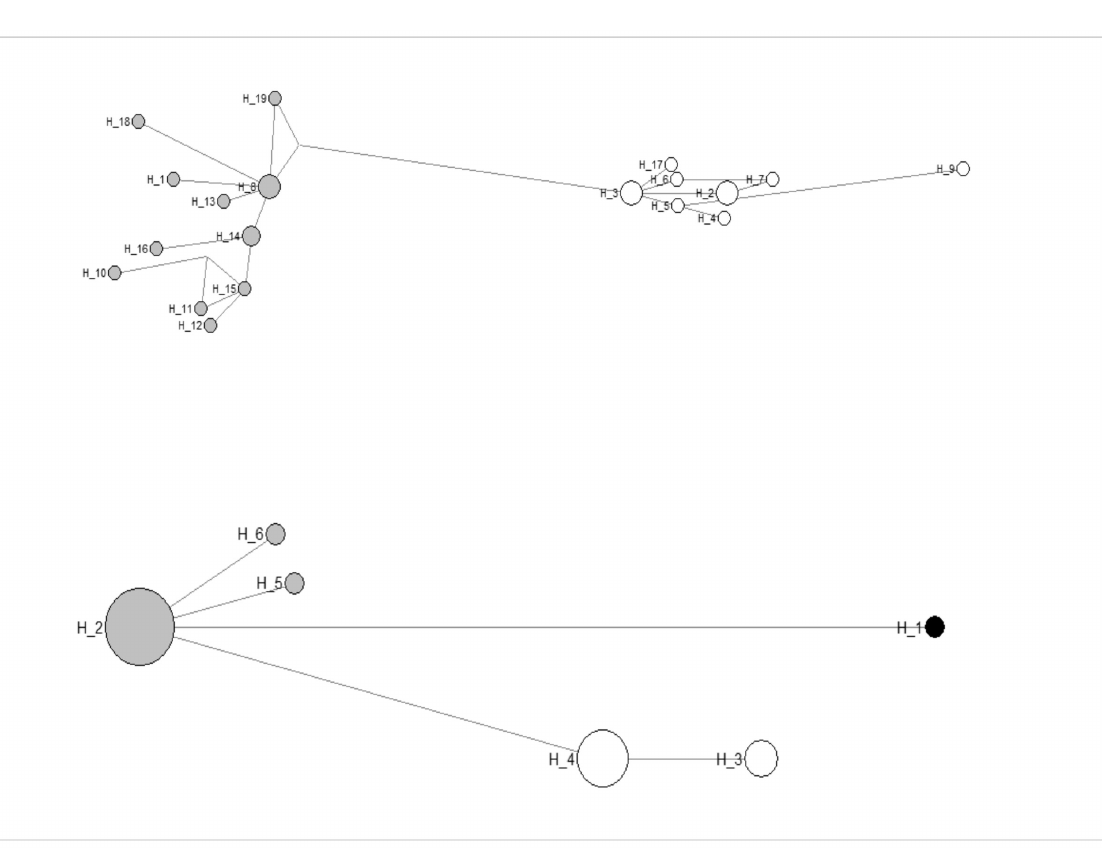
Fig. 5. Median-joining haplotype network for Chrotogale owstoni Thomas, 1912 Cytb haplotypes (top: 837 bp, bottom: 235 bp). The size of each circle is proportional to the haplotype frequency. White = central Vietnam clade; grey = northern Vietnam clade, black =